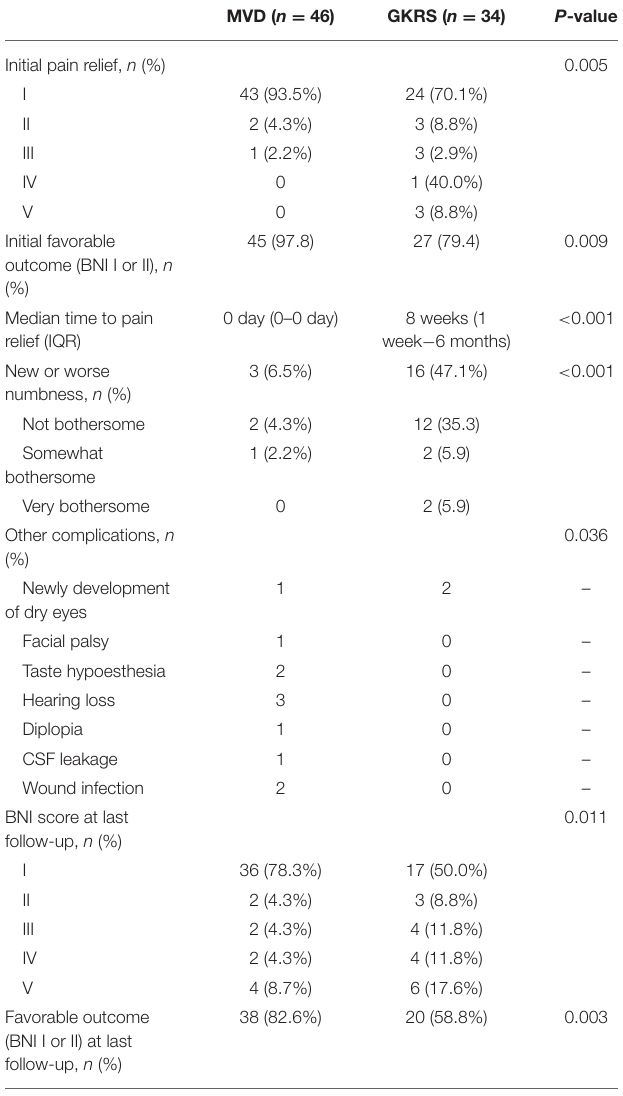
TABLE 2 | Pain outcomes and complications of patients with VBD-TN after MVD and